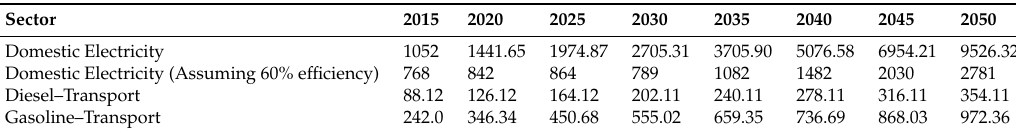
Table 3. Energy Demand Projection [PJ / year].